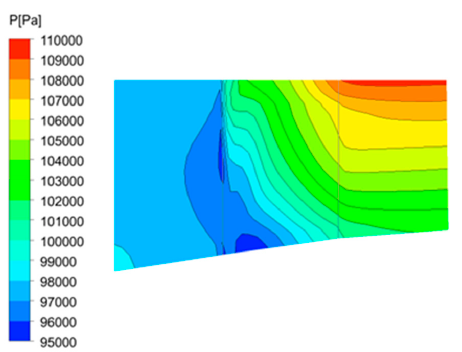
Figure 6. Static pressure P contour of meridional channel. Table 3. Performance of the initial model.